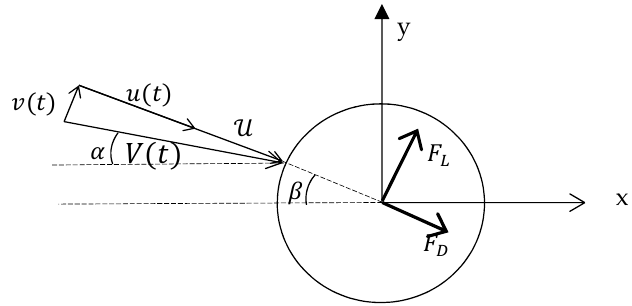
Figure 3. Reference coordinate system, drag force component, lift force component, and wind velocity components.